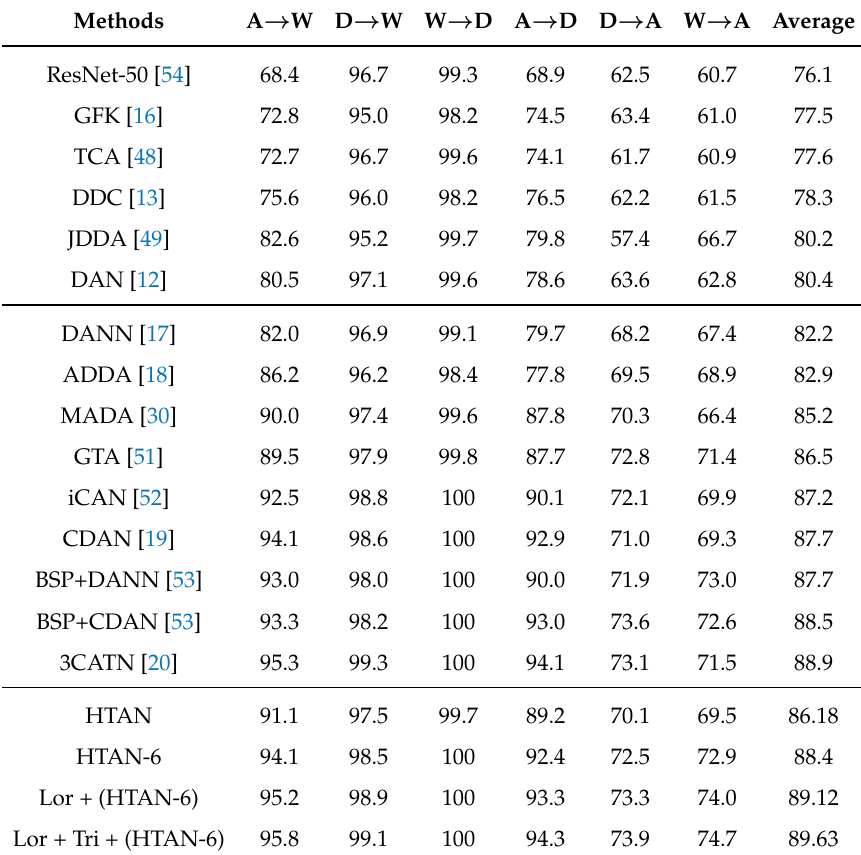
Table 2. Accuracy (%) on the Office-31 dataset for unsupervised domain adaptation (ResNet-50 as base